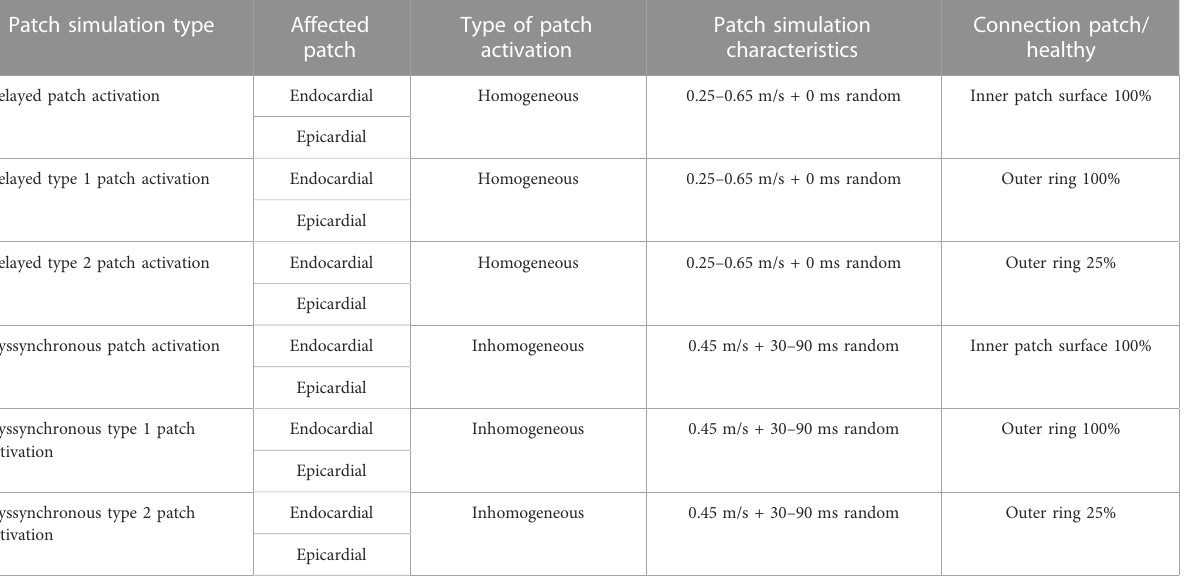
TABLE 1 Summary of patch simulation